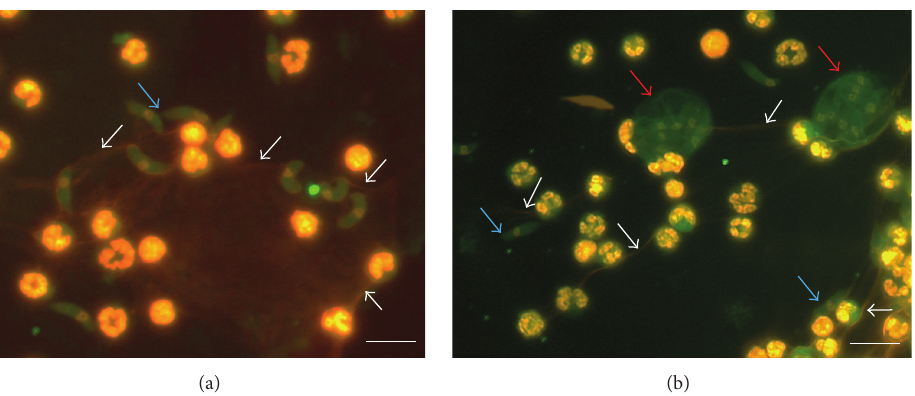
Figure 2: Colocalization of caprine NET-derived DNA and MPO. (a) Cocultures of caprine PMN and Eimeria arloingi sporozoites (blue arrows) were fixed, permeabilized, stained for DNA using Sytox Orange, and probed for MPO using anti-MPO along with adequate conjugate systems (white arrows); (b) cocultures of caprine PMN exposed to sporulated E. arloingi -oocysts (red arrows) and sporozoites (blue arrows). Filigree spread NET structures are indicated by white arrows. Bar scale = 20 𝜇